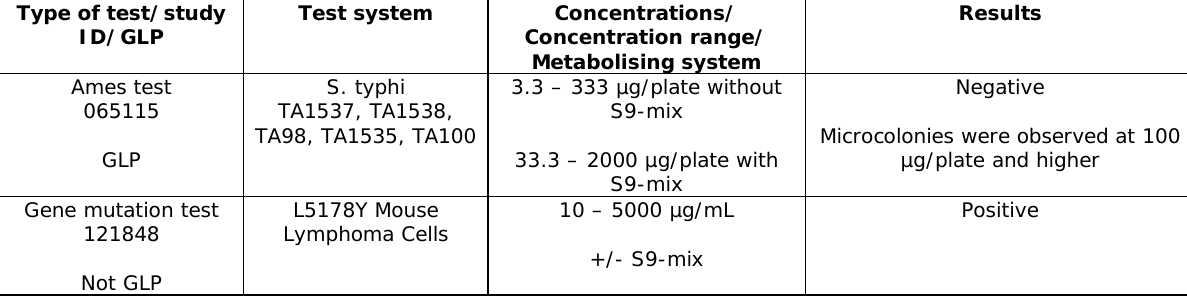
Table 7: Summary of genotoxicity studies Type of test/study